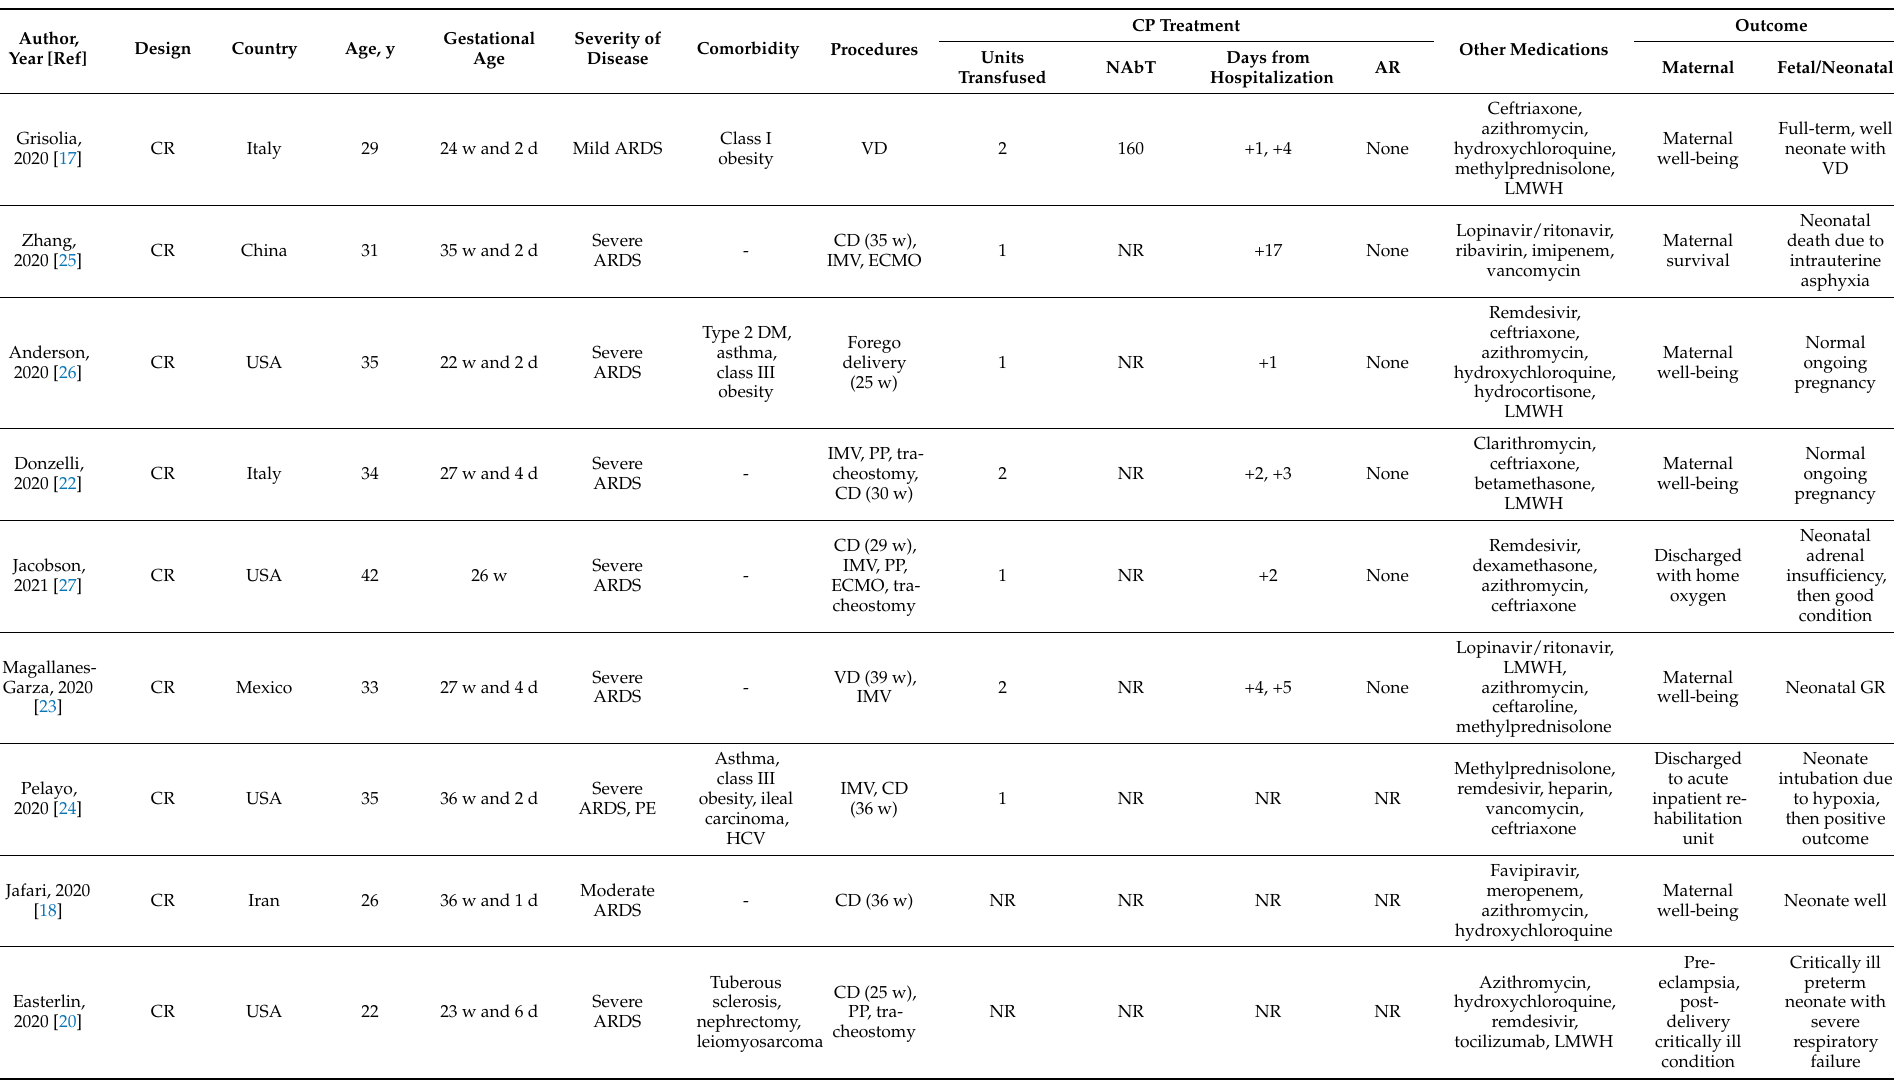
Table 1. Summary of the cases of COVID-19 in pregnant women treated with convalescent